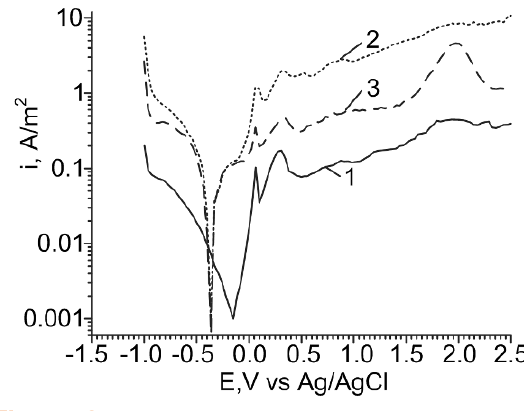
Figure 6. Potentiodynamic polarization curves of Ti-6Al-4V alloy in 0.9% NaCl at 40 o C after nitriding (1); low-temperature oxidation (2) and high-temperature oxidation (3) of nitride coating based on TiN phase.